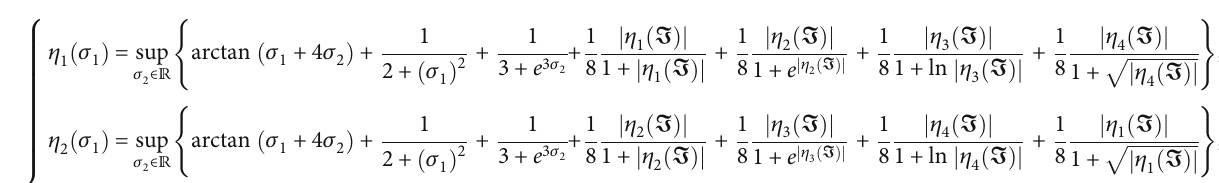
ffiffiffiffiffiffiffiffiffiffiffiffiffiffiffi η 3 I ð Þ